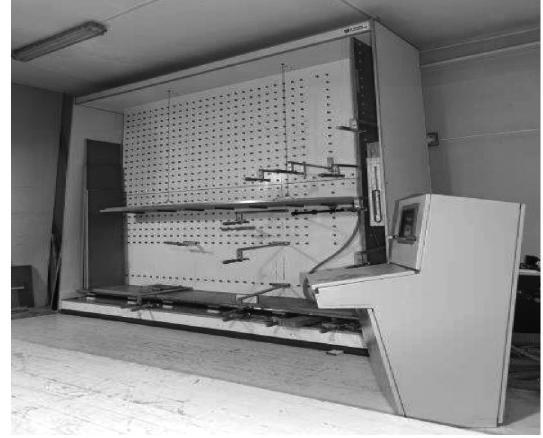
Figure 3. Test rig KS 3025/45 ASD SPS